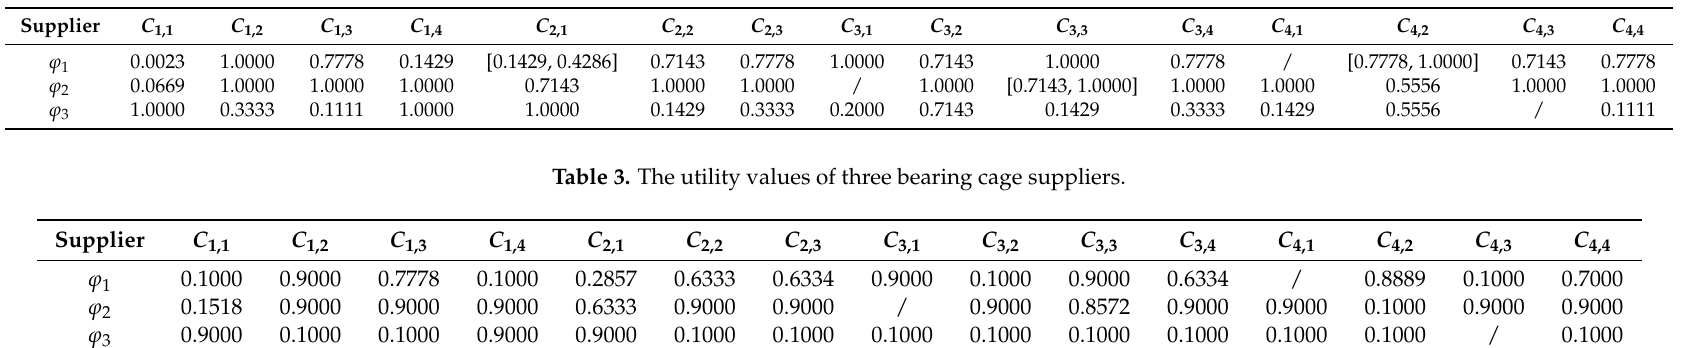
Table 2. The normalized index values of three bearing cage suppliers.